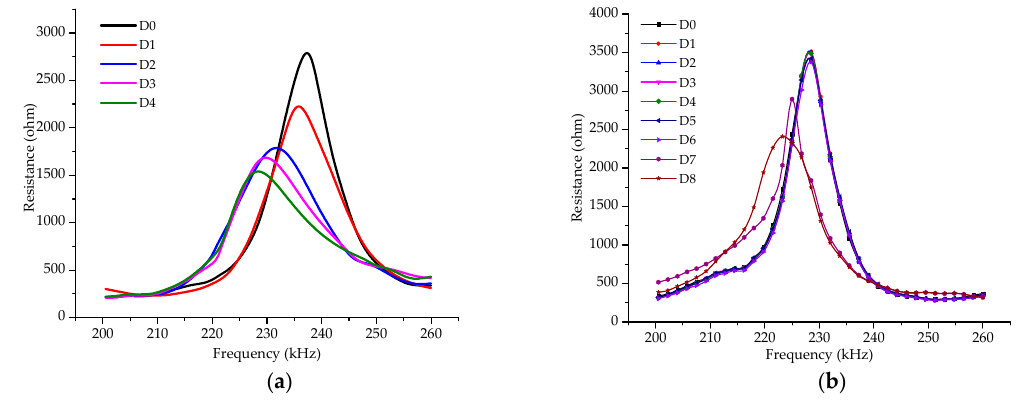
Figure 7. ( a ) Resistance spectra of the PZT-1; ( b ) resistance spectra of the PZT-2.